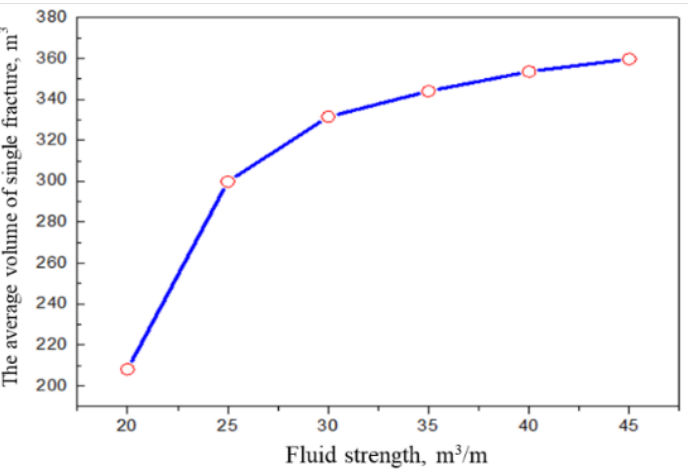
Figure 8. The fracture reconstruction volume under different volume of fracturing fluids.